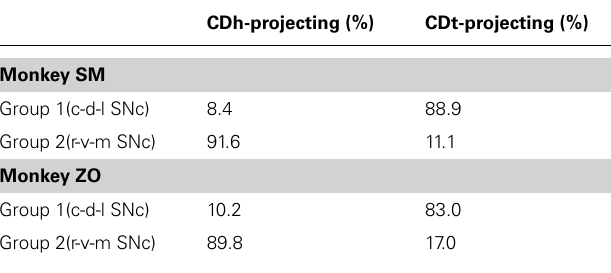
Table 2 | Proportions of CDh and CDt-projecting neurons in two regions of SNc separated by a discriminant plane. CDh-projecting (%) CDt-projecting